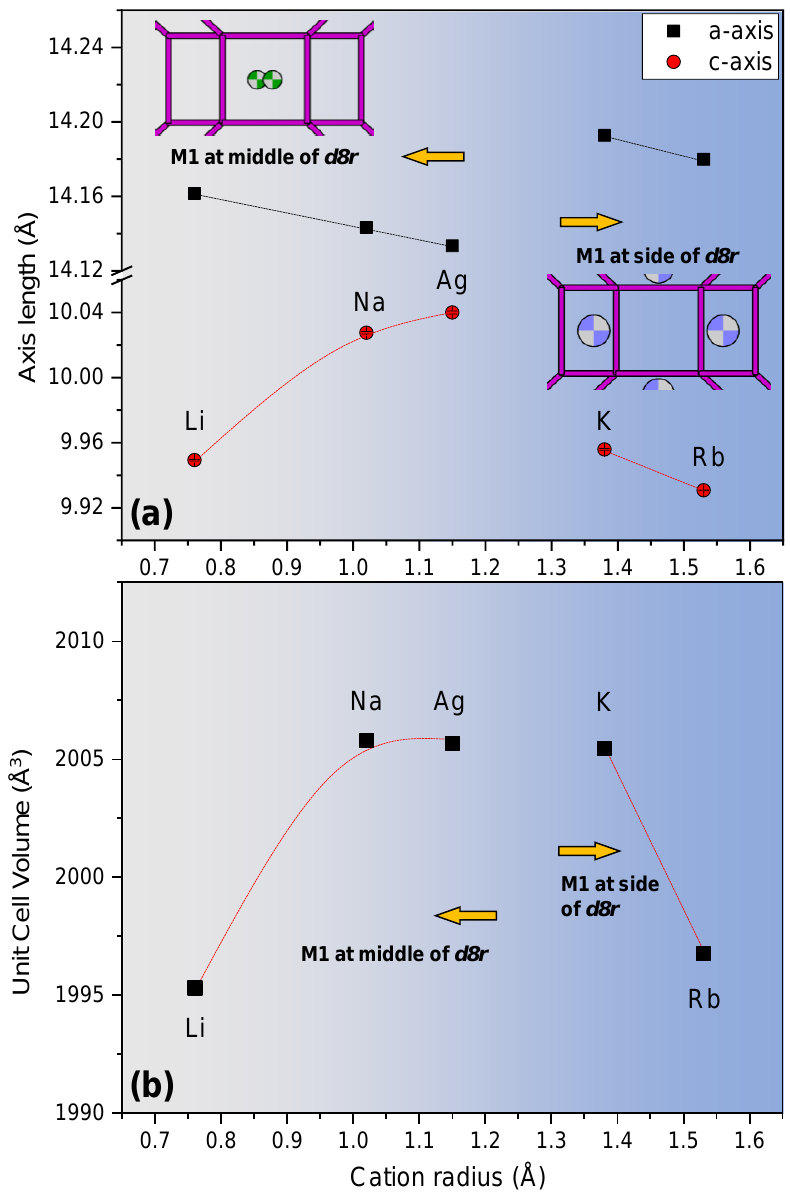
Figure2. Refined( a ) a -and c -axisand( b )volumeofcationformsofMERasafunctionofextra-framework Figure 2. Refined ( a ) a - and c -axis and ( b ) volume of cation forms of MER as a function of extra- cation framework cation size.